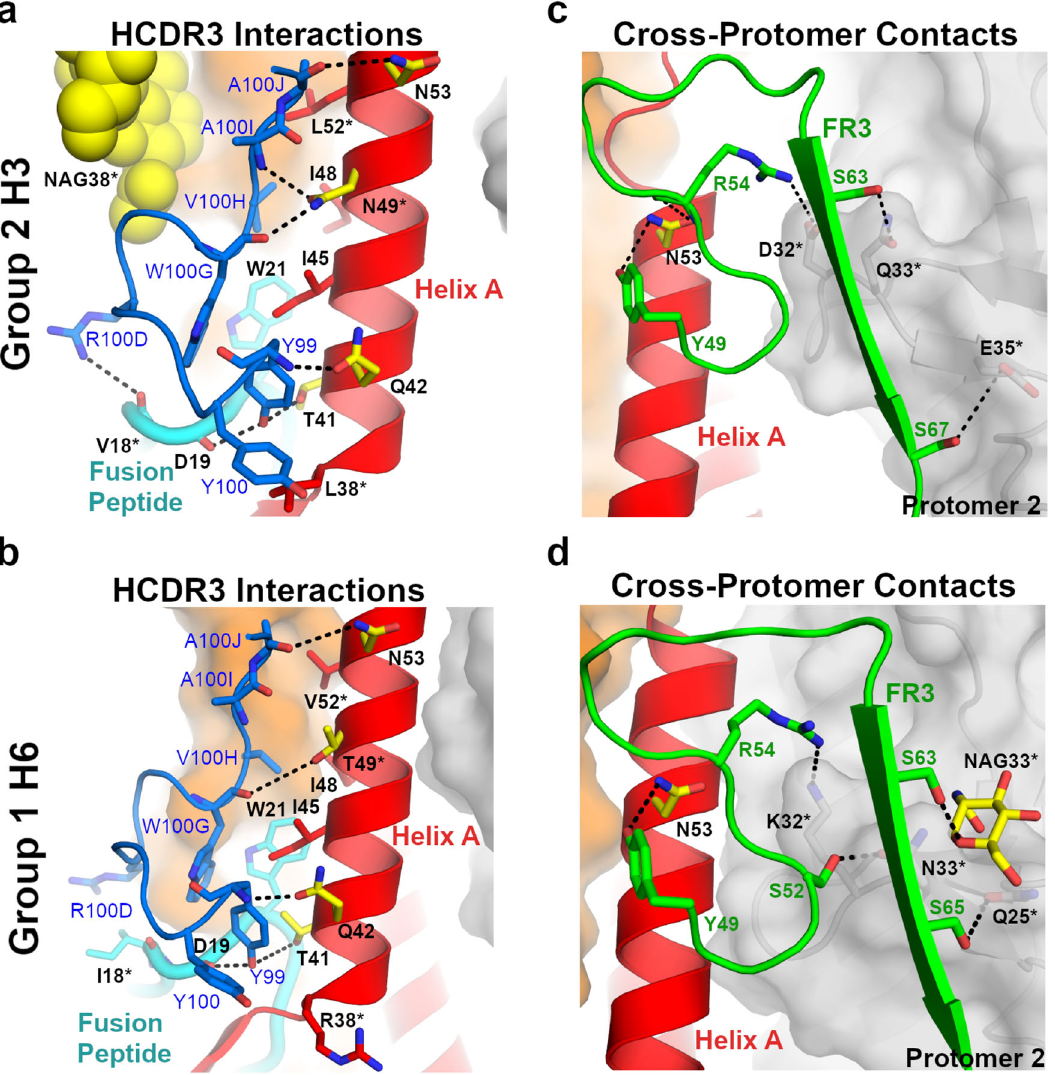
Fig. 2 Binding comparison of 3I14 and 3I14 D93N with group 2 and group 1 HAs. a , b 3I14 HCDR3 interactions with either group 2 H3 ( a ) or group 1 H6 ( b ) HAs. The 3I14 HCDR3 is colored blue with residues that make either polar or vdWs interactions shown as sticks and labeled in blue. The HA helix A is shown in cartoon and colored red, the fusion peptide is colored cyan, HA1 is colored orange, and the group 2-speci fi c glycan is shown as yellow spheres. Helix A residues that make polar interactions are shown as yellow sticks, whereas vdWs contacts are shown as red sticks. Dashed lines indicate hydrogen bonds. Residues that differ between group 1 and group 2 HAs are indicated with an asterisk. c , d 3I14 LCDR2 and FR3 interactions, highlighting cross- protomer contacts. 3I14 light chain is colored green and shown as cartoon with green labels. HA coloring and labels follow that of ( a , b ), except the group 1- speci fi c glycan is shown as yellow sticks. Protomer 2, which is buried by FR3, is colored